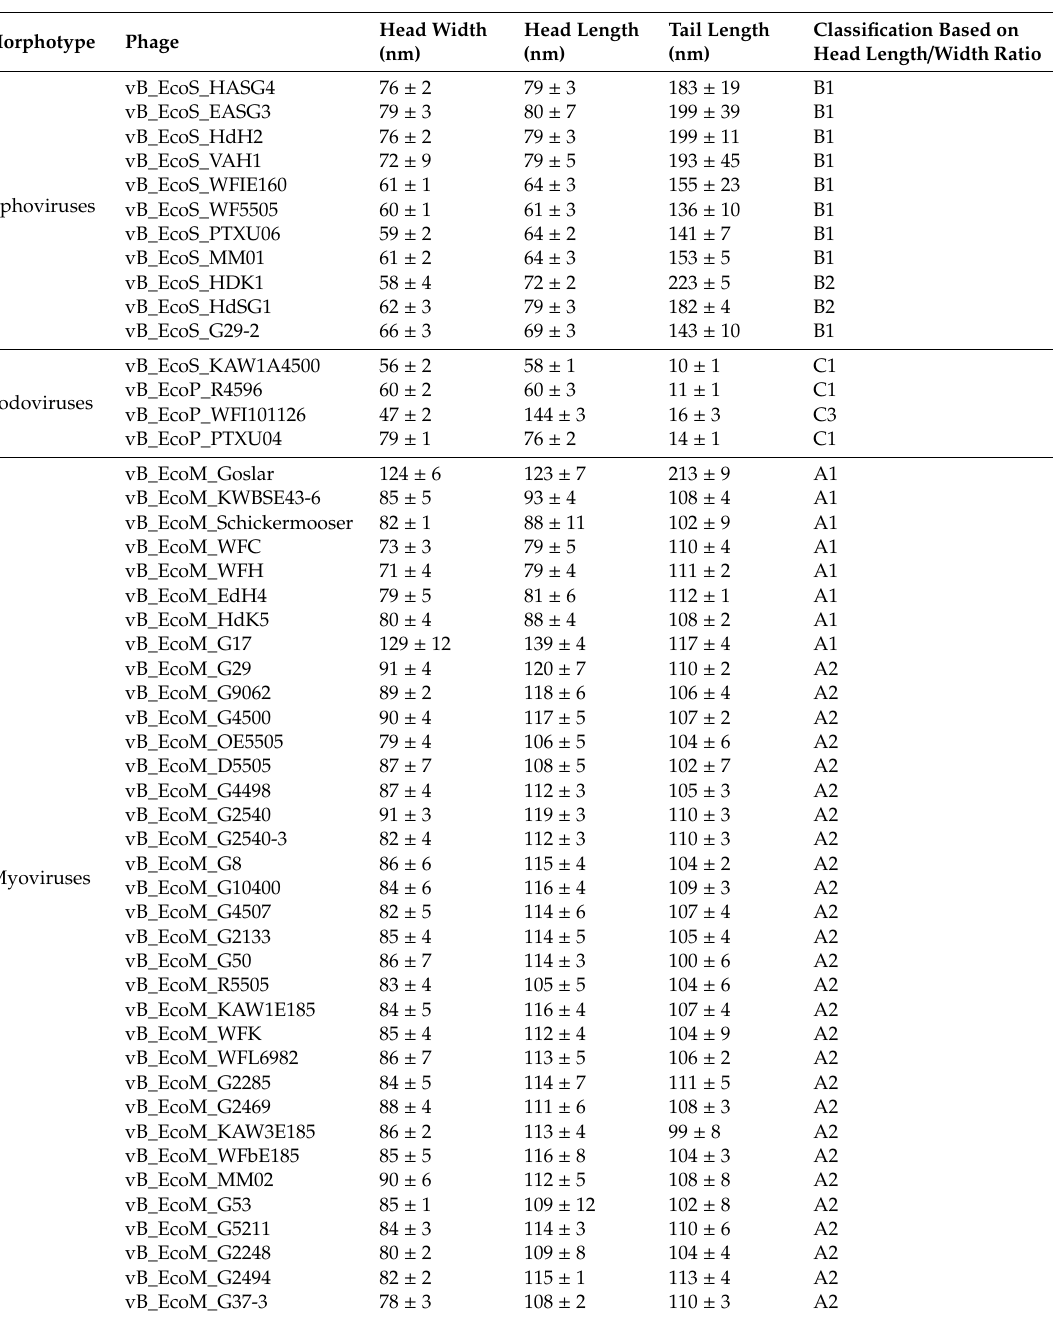
Table 1. Morphological analysis of isolated